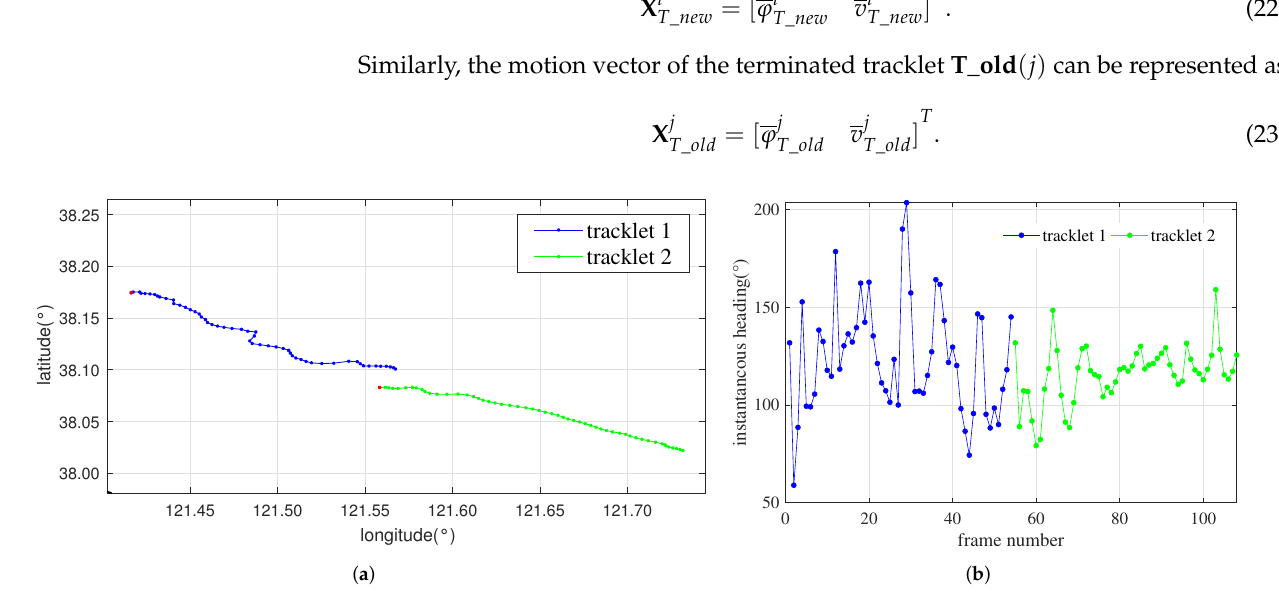
Figure 2. Analysis of the instantaneous headings. ( a ) The tracklet examples. ( b ) The estimation results of instantaneous